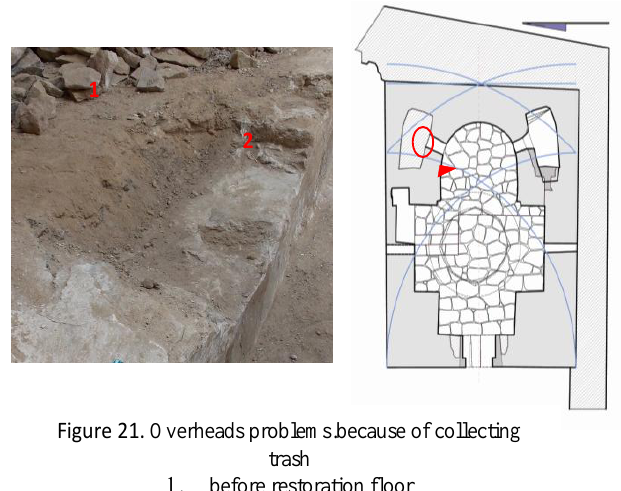
Figure 21. Overheads problems.because of collecting